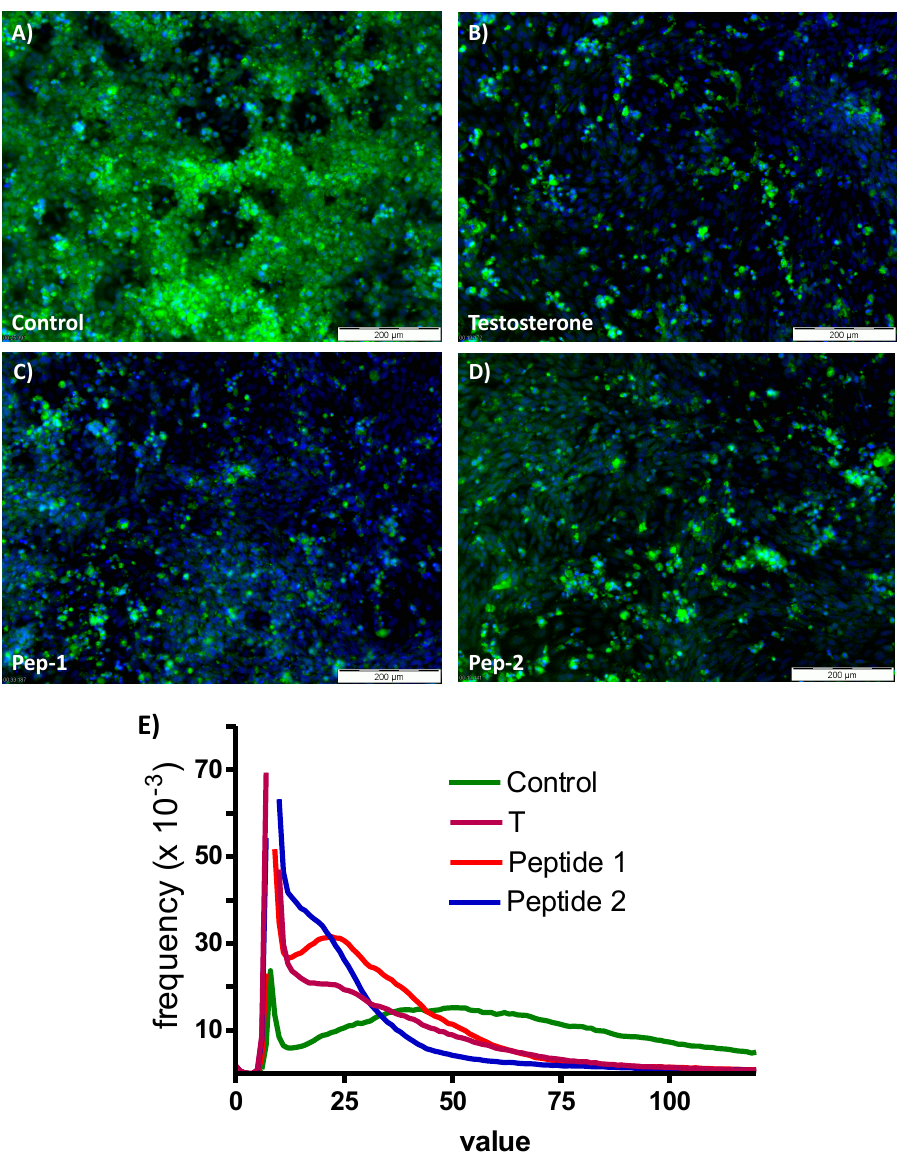
Figure 6. Detection of alkaline phosphatase in SAOS-2 cells by immunofluorescence. In all frames alkaline phosphatase is indicated by the green fluorescence and nuclei are stained blue by DAPI. ( A ) Expression of alkaline phosphatase in SAOS-2 cells in the absence of testosterone or peptides. ( B ) Expression of alkaline phosphatase in the presence of testosterone. ( C , D ) Expression of the same enzyme in the presence of Pep-1 or Pep-2, respectively. ( E ) Plots of green fluorescence intensity versus frequency obtained in the presence of testosterone, Pep-1, or Pep-2 are highly divergent from that of the control. Testosterone and both Pep-1 and Pep-2 were also found to stimulate mineralization and calcium deposits in SAOS-2 osteogenic cells. As shown in Supplementary Figure S3, positive Alizarin Red staining was already clearly visible four days after the incubation of the